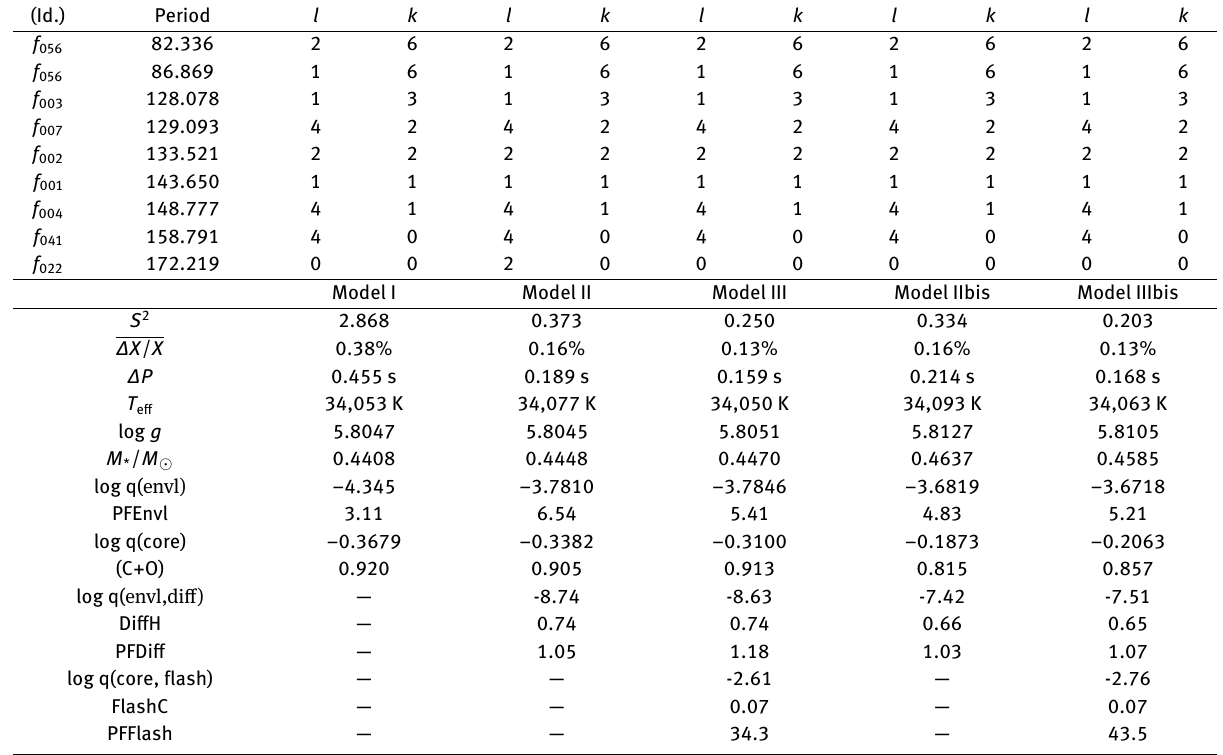
Figure 5. Optimization with 3G models. Left panel : Map of the projected merit function S 2 (on a logarithmic scale) in the log q (envl)– M * plane. At each M * , log q (envl) position, the value given is the minimum of log S 2 that can be found among the values obtained for all log q (core) and X core ( C + O ). Right panel : Map of the projected merit function S 2 (on a logarithmic scale) in the log q (core)– X plane where the best-fit model is indicated by a star. White contours show regions where the period fits have S 2 values within the 1 σ , 2 σ and 3 σ confidence levels relative to the best-fit solution. Table 2. Optimal 4G models and their mode identification for the nine independent p -modes.